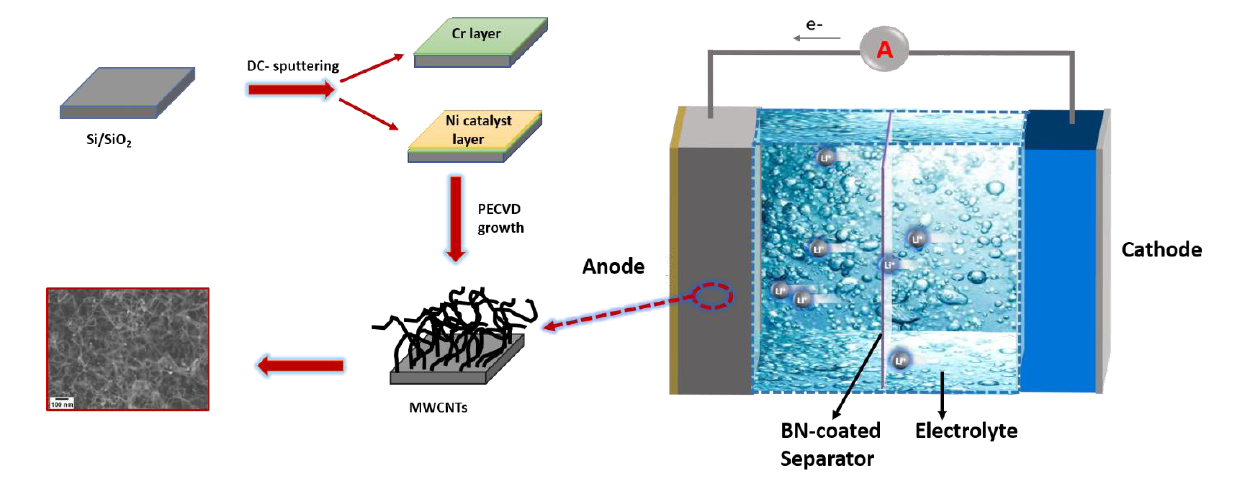
Figure 1. Schematic representation of the growth of MWCNTs on Si/SiO 2 substrate and the fabrica- tion of Li-ion batteries using MWCNTs anode and BN-coated separator.